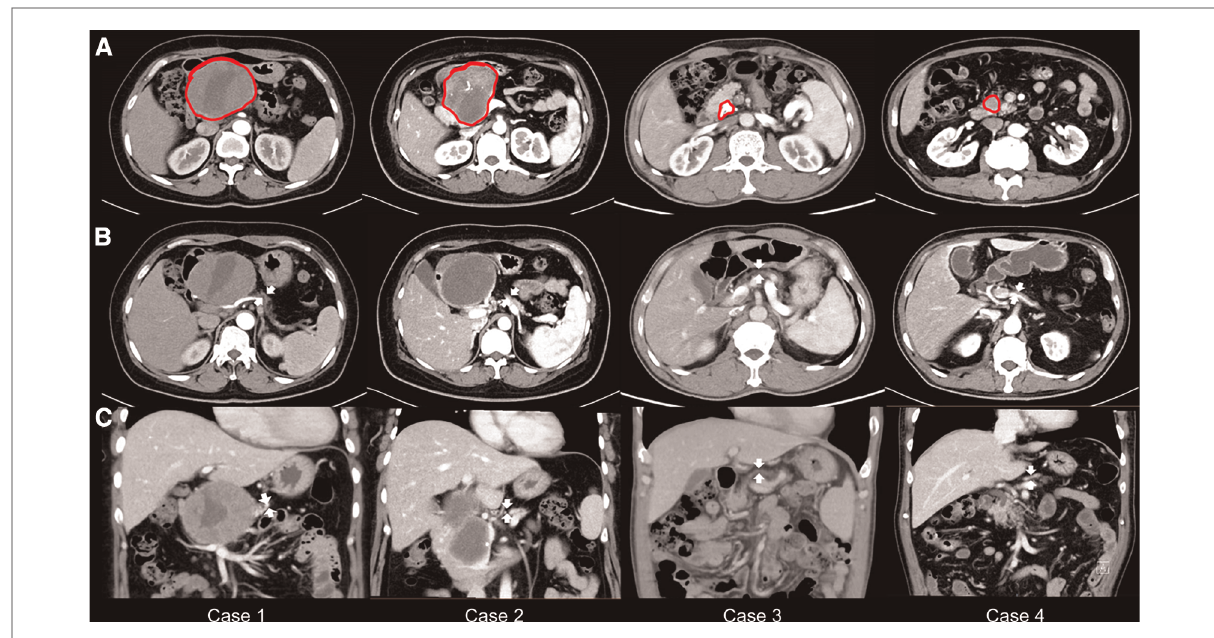
FIGURE 1 Preoperative abdominal computed tomography scans. ( A ) The tumor or stone is marked in red. ( B ) The width of the pancreatic bodies is<10 mm, with arrows highlighting the atrophy of the pancreatic bodies. ( C ) The thickness of the pancreatic bodies is<10 mm in the image, with arrows indicating the atrophy of the pancreatic bodies.